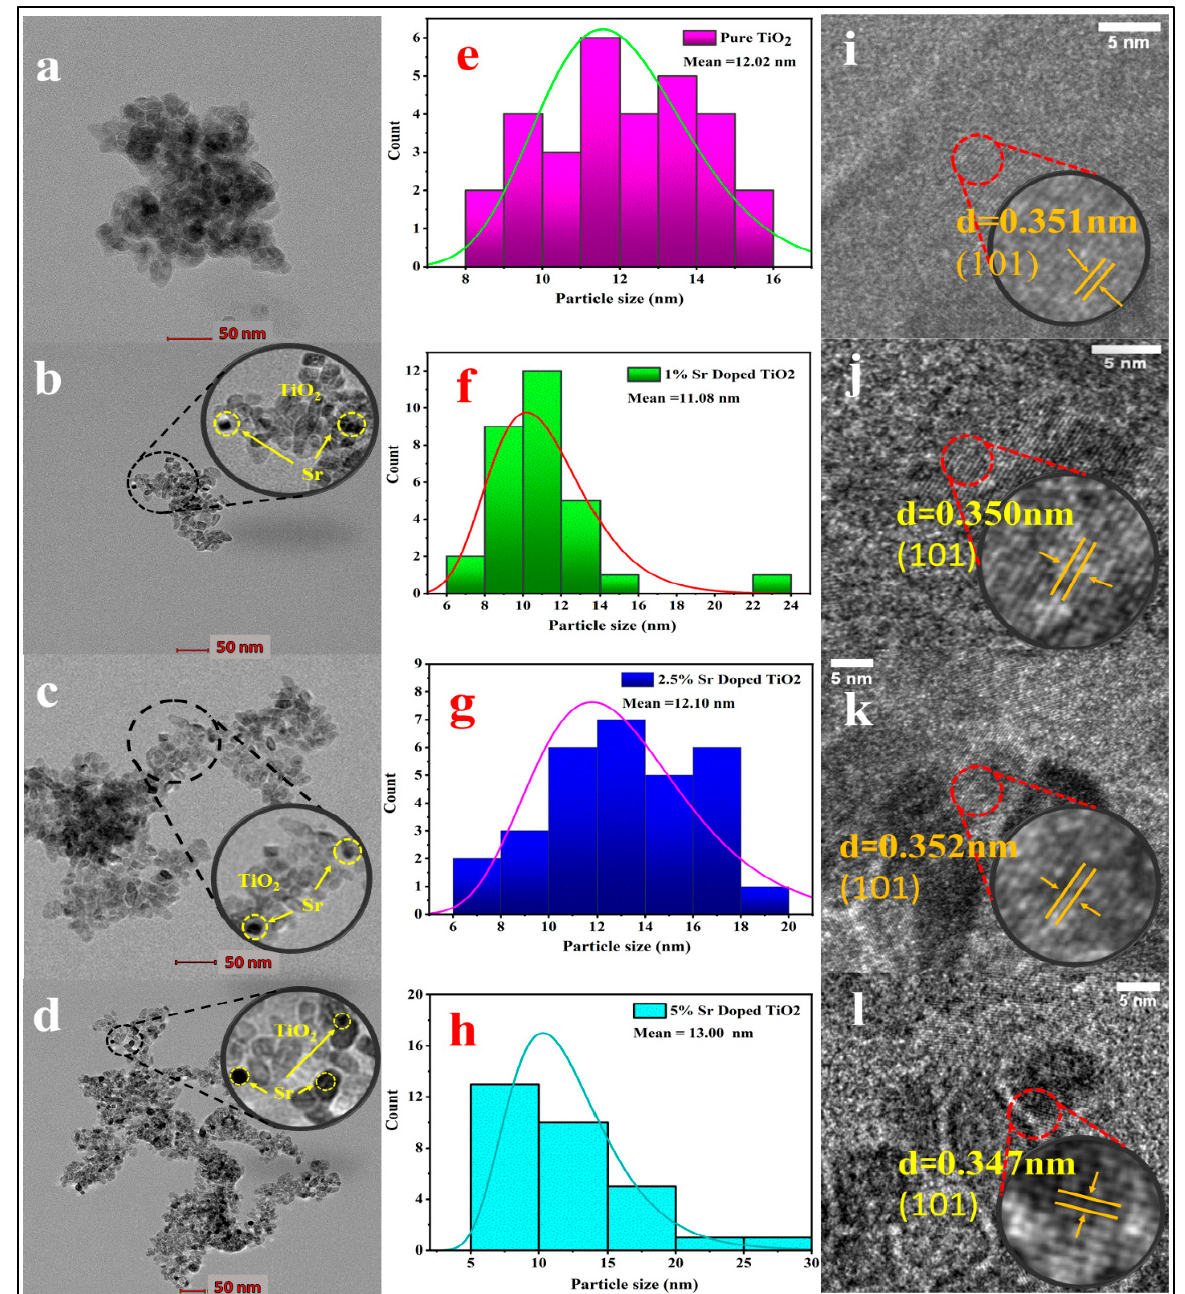
Figure 4. ( a – d ) TEM micrographs, ( e – h ) size distribution plots and ( i – l ) HRTEM micrographs depicting the lattice spacing of the crystallographic planes of pristine TiO 2 and 1%, 2.5% and 5% Sr-doped TiO 2 nanoparticles.